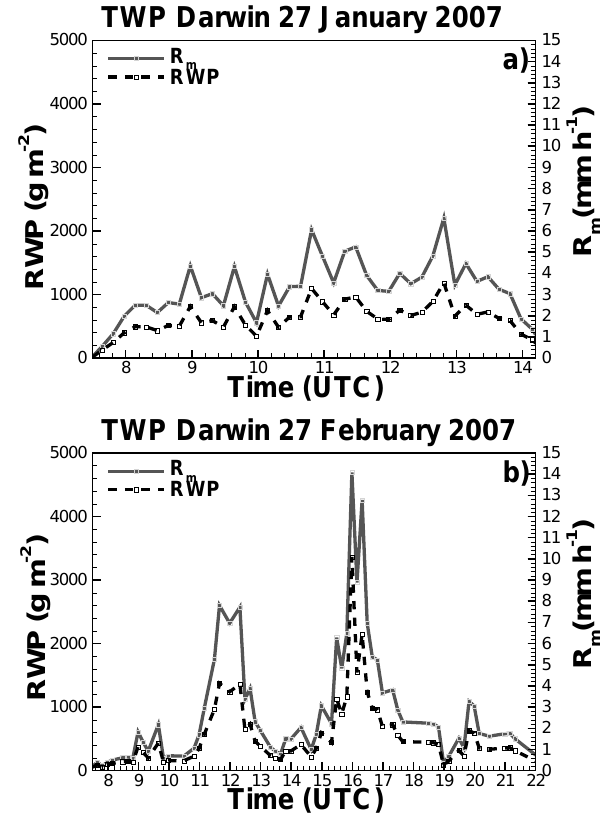
Fig. 9. Retrievals RWP and mean layer rain rate during the 27 January 2007 (a) and 27 February 2007 (b) stratiform precipitating